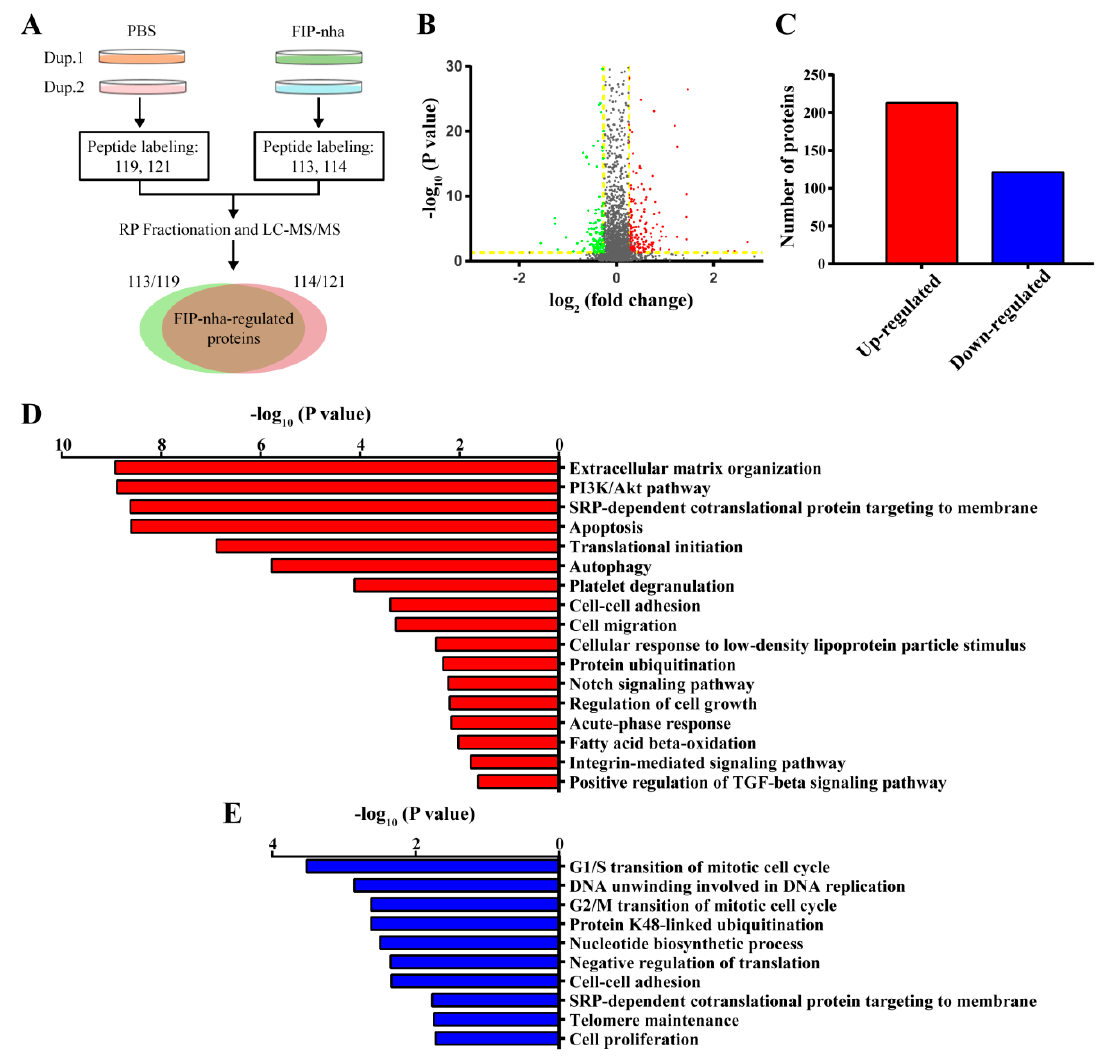
Figure 2. iTRAQ proteomic analysis of differential protein expression in A549 cells after FIP-nha treatment. ( A ) Experimental flow diagram of proteomic analysis. Dup: biological duplicate; RP: reversed phase chromatography. ( B ) Volcano plot of identified proteins. The proteins were indicated in color as follows: green, fold change ≤ 0.83, p ≤ 0.05; red, fold change ≥ 1.2, p ≤ 0.05; gray, 0.83 <